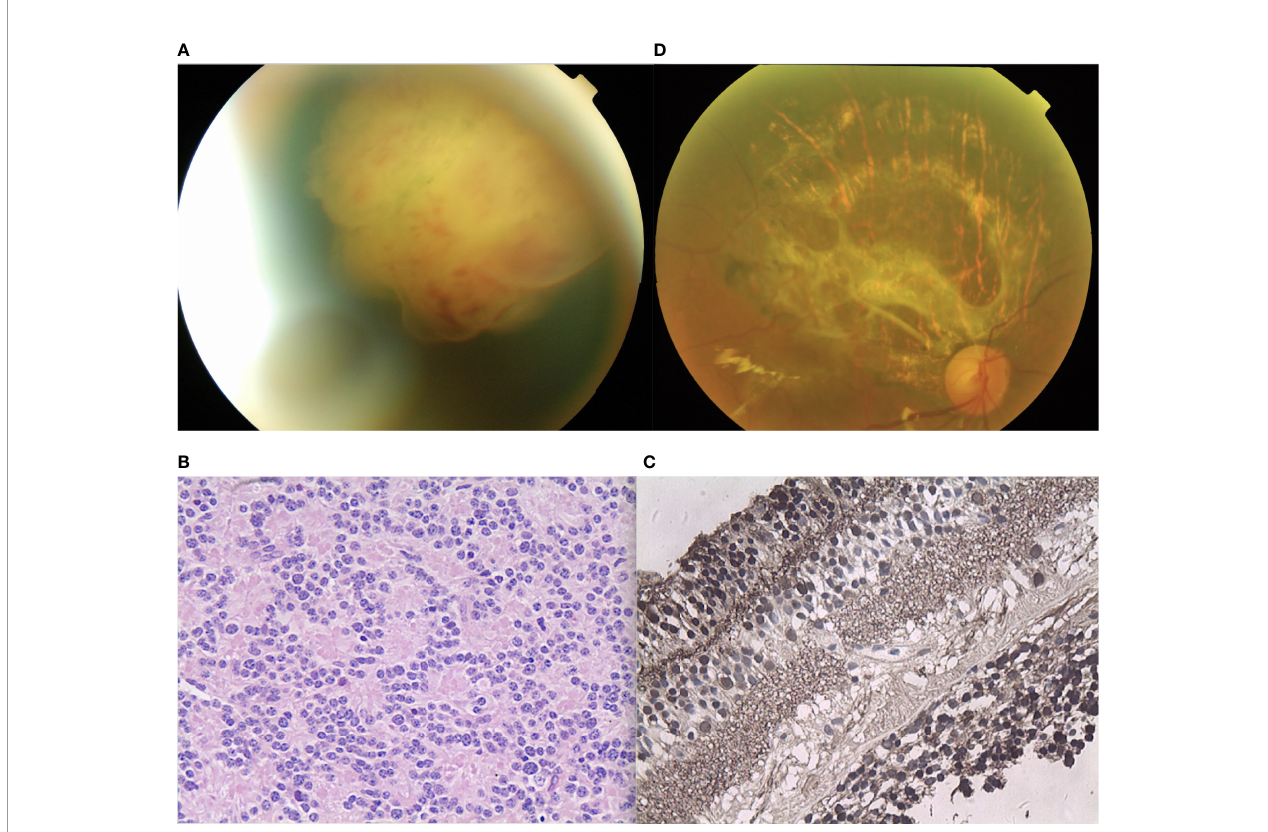
FIGURE 4 | (A) The peripheral portion of the lesion in patient 4 was fl at and white, while the central portion was elevated. Fine retinal vessels on the surface were observed. (B, C) Pathology and immunohistochemistry results revealed the foci of (B) Flexner-Wintersteiner rosettes that were (C) NSE positive. (D) In the last follow-up, the retina was well-attached and there was slight proliferation in the defect area of the